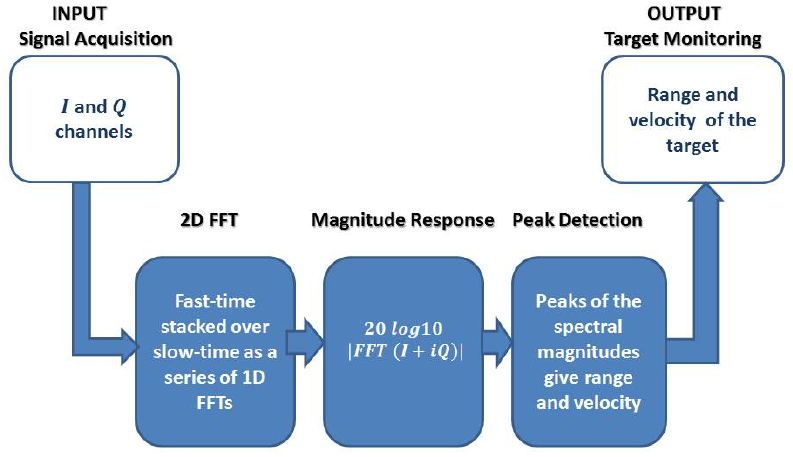
Figure 4. The general architecture of the radar signal processing using I and Q input channels. The output includes the velocity and the distance of the target.